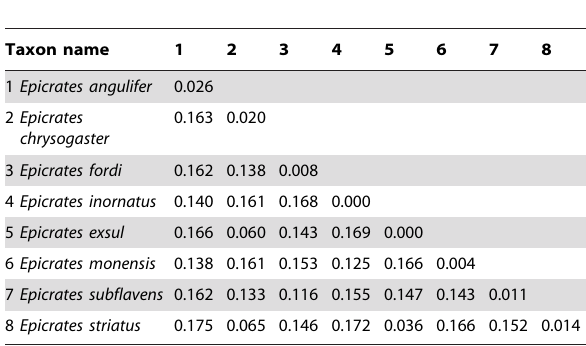
Table 3. Kimura’s two parameter (K2P) distance, for cytochrome b , within and among Caribbean Epicrates spp.